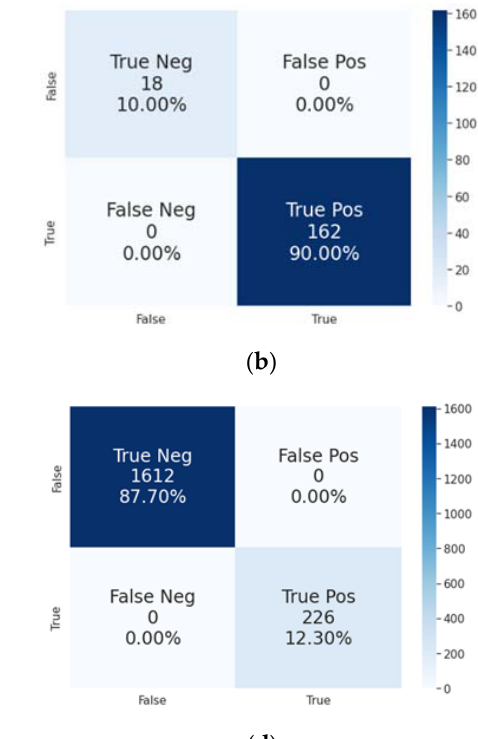
( f ) Figure 8. Training and testing loss distribution with number of samples: ( a ) MIT ‐ BIH training data;